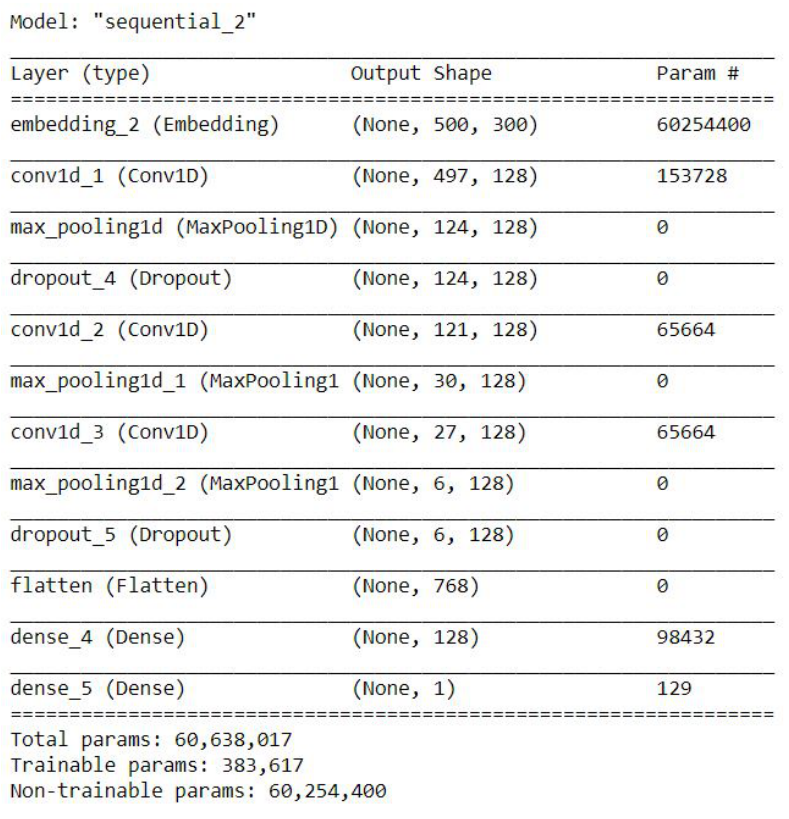
Figure 6. CNN with DeepNetwork